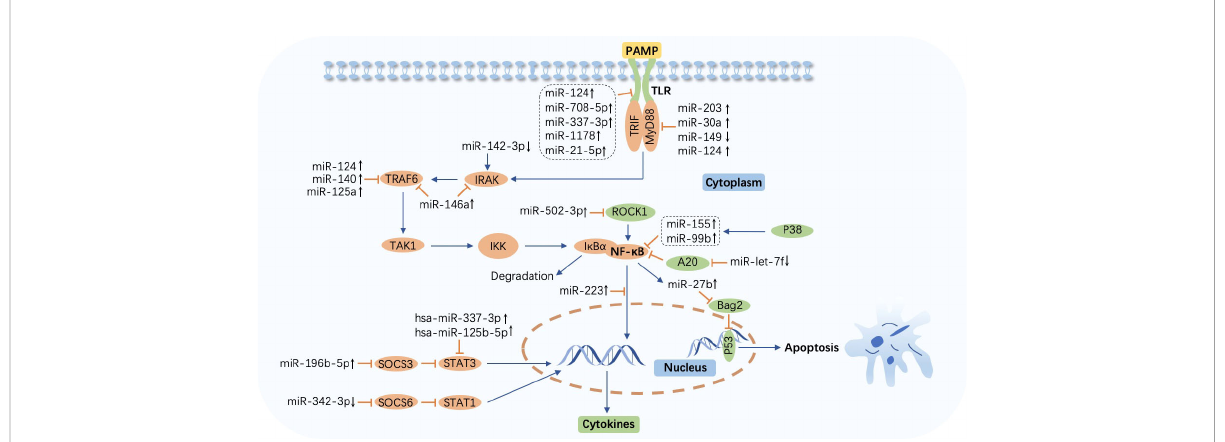
FIGURE 2 MicroRNA-regulated signaling pathway during Mycobacterium tuberculosis infection. The Toll-like receptor (TLR)/nuclear factor- k B (NF- k B) pathway is activated by the combination of TLRs and pathogen-associated molecular patterns (PAMPs) and impacts cytokine production. Abundant molecules such as TAK1 and I k B kinase (IKK) participate in this process. I k B a is degraded after the release of NF- k B from IKK. Overexpressed or downregulated microRNAs (miRNAs) target myeloid differentiation factor 88 (MyD88), Toll-interleukin (IL)-1-resistance (TIR) domain-containing adaptor inducing interferon- b (TRIF), IL-1R-associated kinase (IRAK), tumor necrosis factor (TNF) receptor-associated factor (TRAF), NF- k B, suppressor of cytokine signaling (SOCS), signal transducer and activator of transcription (STAT), and p53 to affect host immune cell response in tuberculosis. miR-27b is induced by NF- k B and triggers p53-dependent apoptosis by targeting Bcl-2 associated athanogene 2 (Bag2). ↑ , upregulated; ↓ , downregulated; ⟶ , stimulate; ⟞ ,